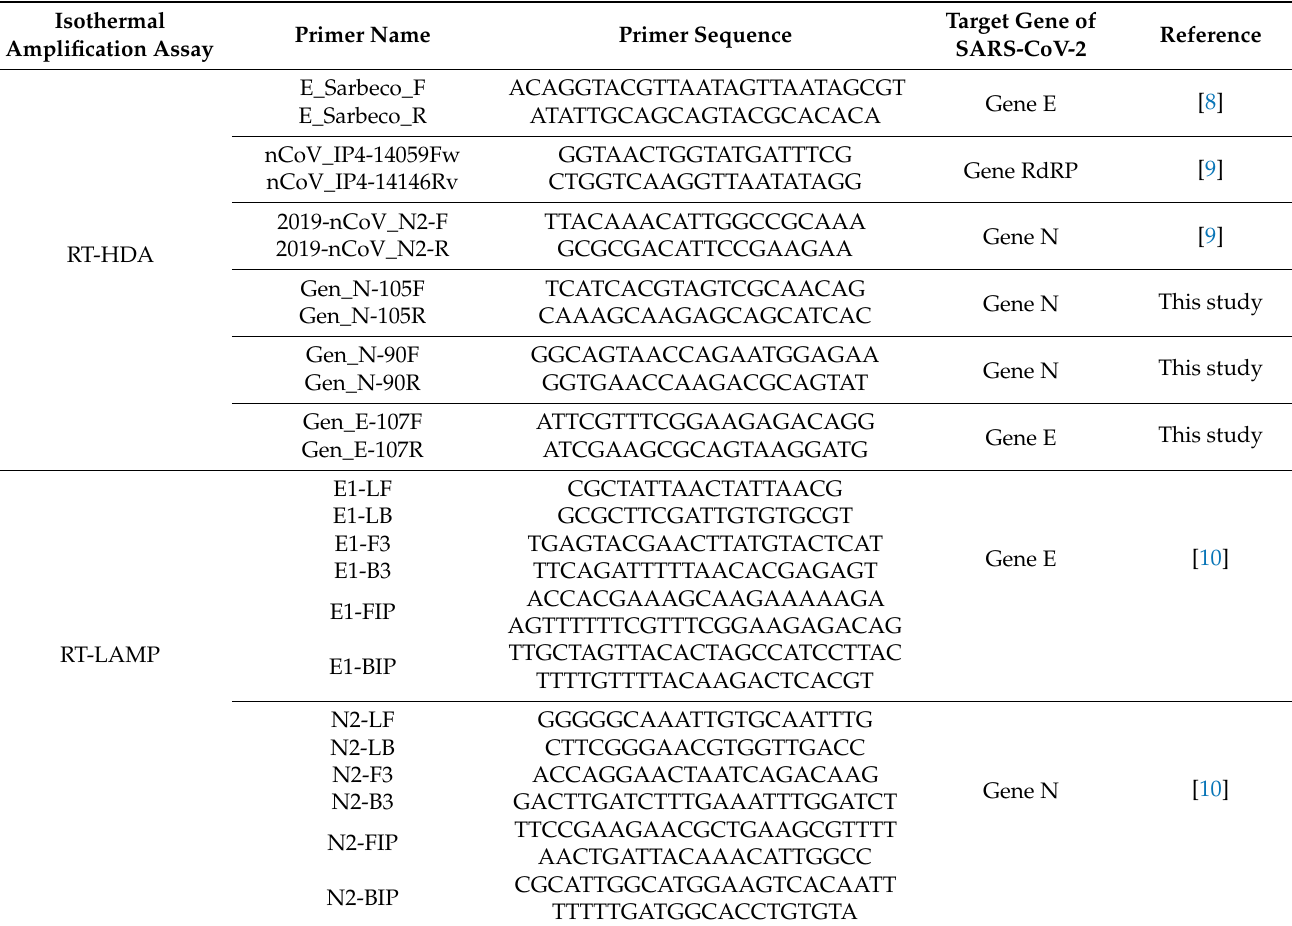
Table 2. Primer sets used in the